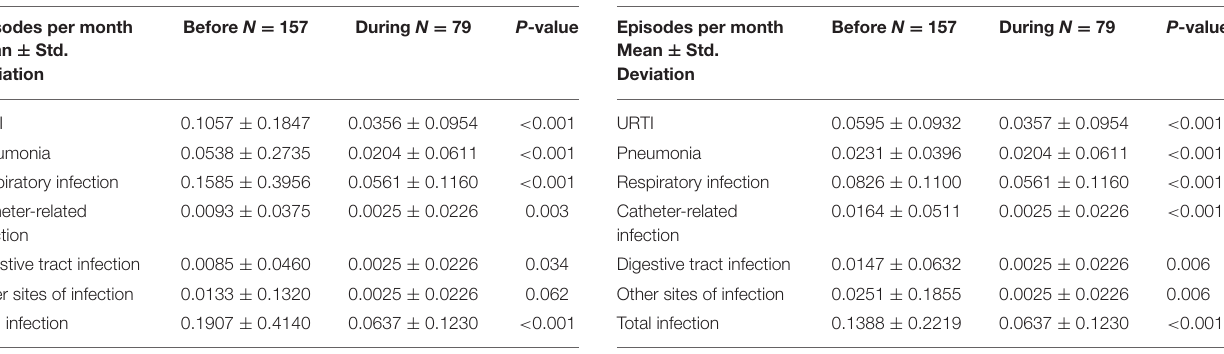
Frontiers in Public Health |